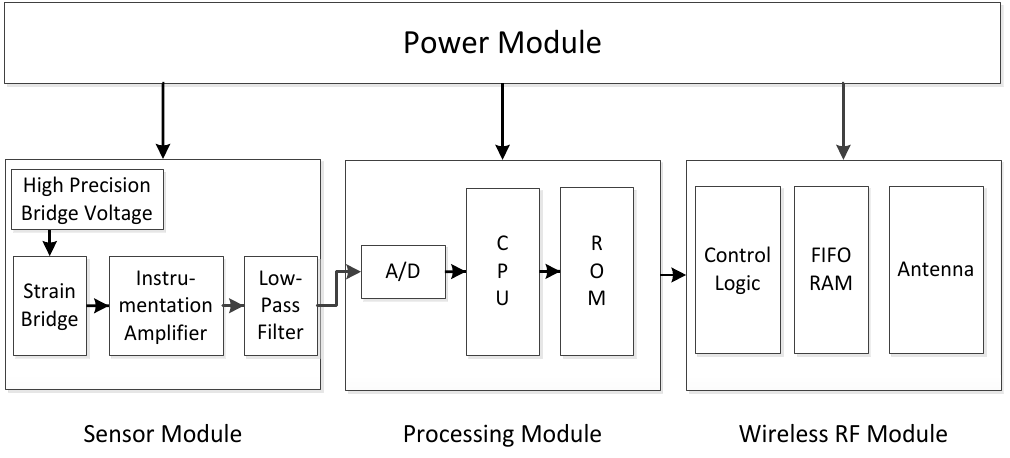
Figure 3. A typical WSN strain sensor node structure.